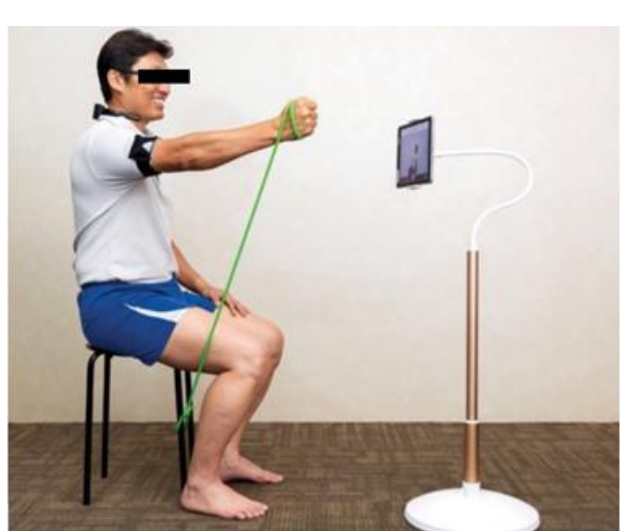
Figure 3. Final set-up